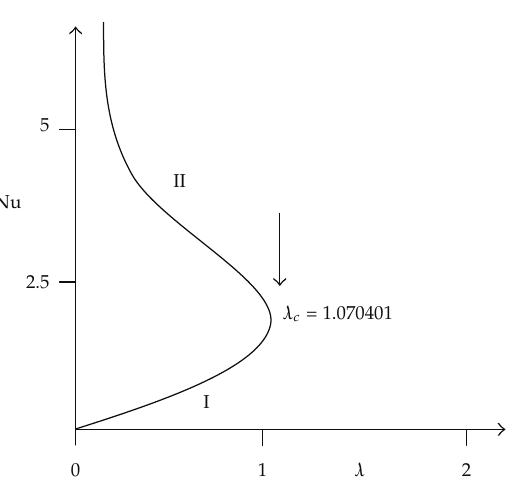
Figure 2: A slice of approximate bifurcation diagram in the (cid:5) λ , Nu (cid:5) β (cid:8) n (cid:8) 1, θ w (cid:8) ε (cid:8) 0 (cid:6)(cid:6) plane.